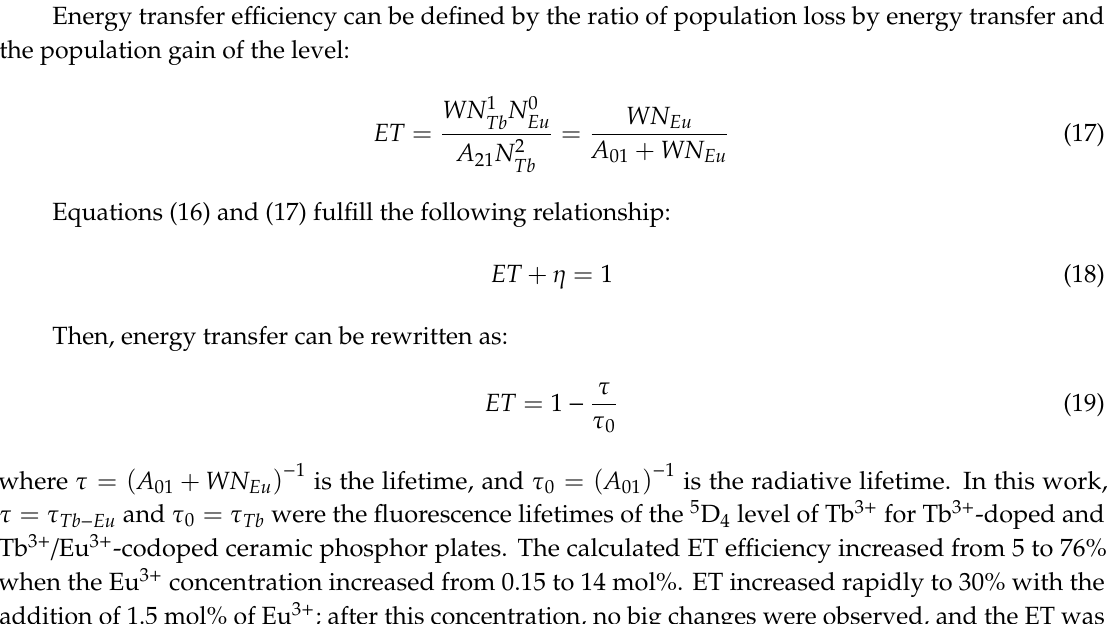
Figure 10. Electroluminescent spectra of LEDs fabricated using a 380 nm UV LED chip combined with Tb 3+ -doped and Tb 3+ /Eu 3+ -codoped ceramic phosphor plates under a forward bias of 20 mA. Figure 11 shows the color coordinates of the samples under study. The values were located on the edge of the chromaticity diagram, predominantly in yellow and red regions. The emitted color of the device changed from green to red through warm white by keeping the Tb 3+ concentration and changing the Eu 3+ content. The obtained results showed that the optical properties of LED were strongly influenced by Eu 3+ content. Interestingly, by doping with only 0.15 mol% of Eu 3+ , it was possible to modify both CRI and CCT. CRI showed an increase from 34 to 74.81, and CCT diminished from 5497 to 3658 K; these features were very adequate for indoor lighting. The samples with 0.3 and